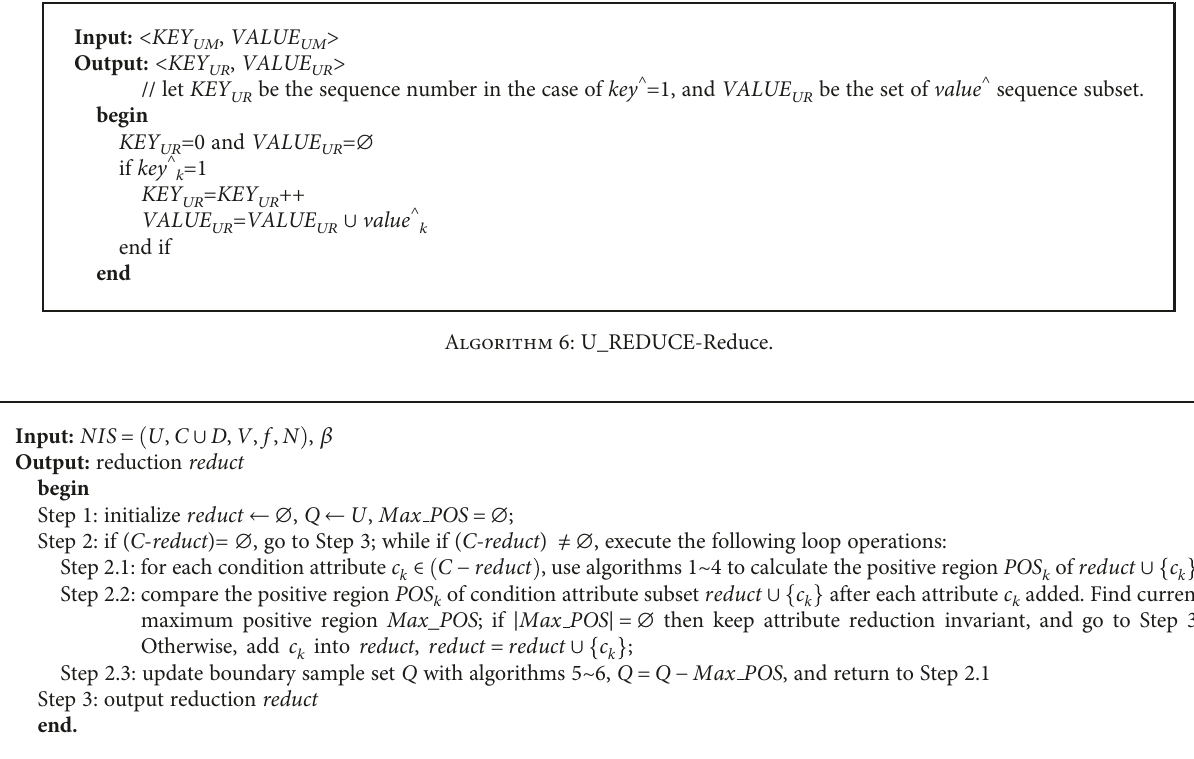
Algorithm 7: PARA_NMG algorithm. Table 4: Classi fi cation accuracies with two algorithms ’ reduction